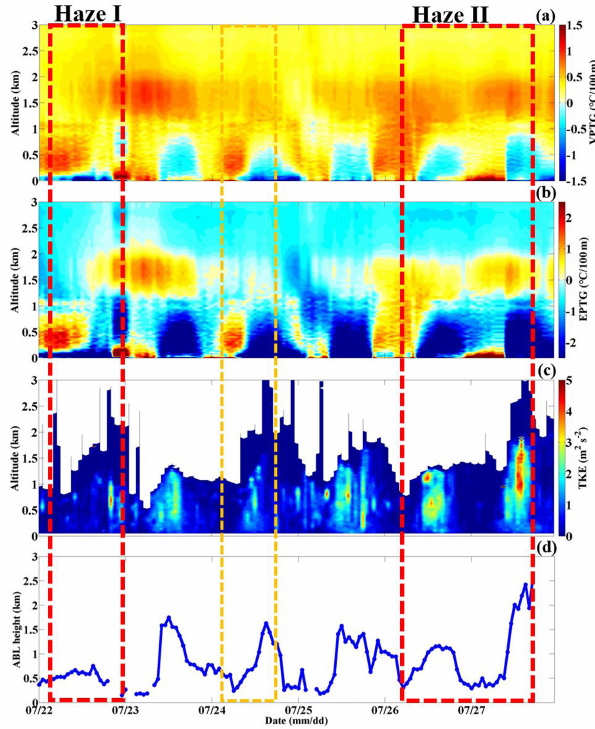
Figure 5. Temporal variation in the vertical profiles of the (a) virtual potential temperature gradient (VPTG: ∂θ v /∂z ), (b) pseudoequiva- lent potential temperature gradient (EPTG: ∂θ se /∂z ) and (c) turbu- lent kinetic energy (TKE), along with the corresponding (d) atmo- spheric boundary layer height (ABLH) at the BJ site from 22 to 27 July, 2019 (the yellow box represents the light-haze pollution pe- riod, and the red box represents the heavy-haze pollution